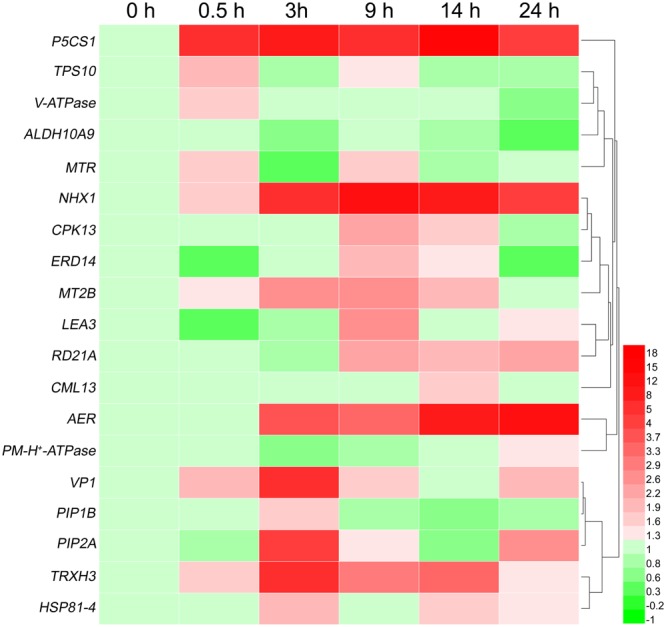
Heat-map of differentially expression of 19 select genes at six time points of salt shock. Each line represents a different gene. Each color represents a different gene expression level. qRT-PCR was used to evaluate the relative levels of the 19 unigenes at six time points of 500 mM NaCl shock. The patterns were clustered and visualized by heatmap program HemI 1.0 (Deng et al., 2014).